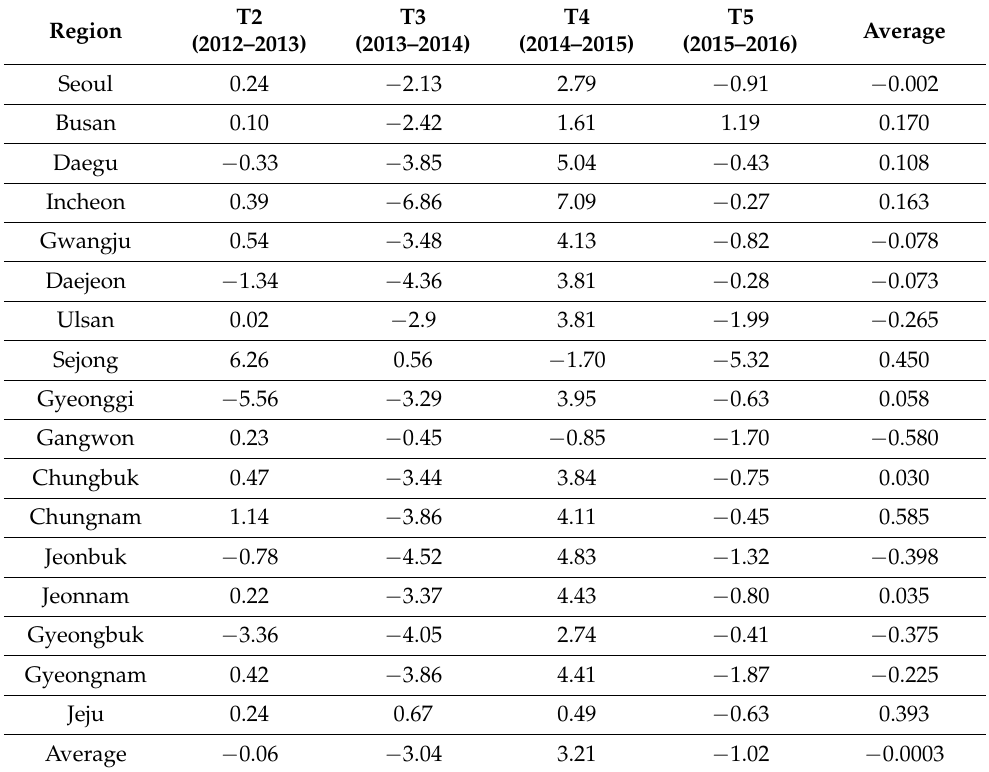
Table 5. The changes in the proportion of educational expenditure of kindergarten, primary, and secondary education.